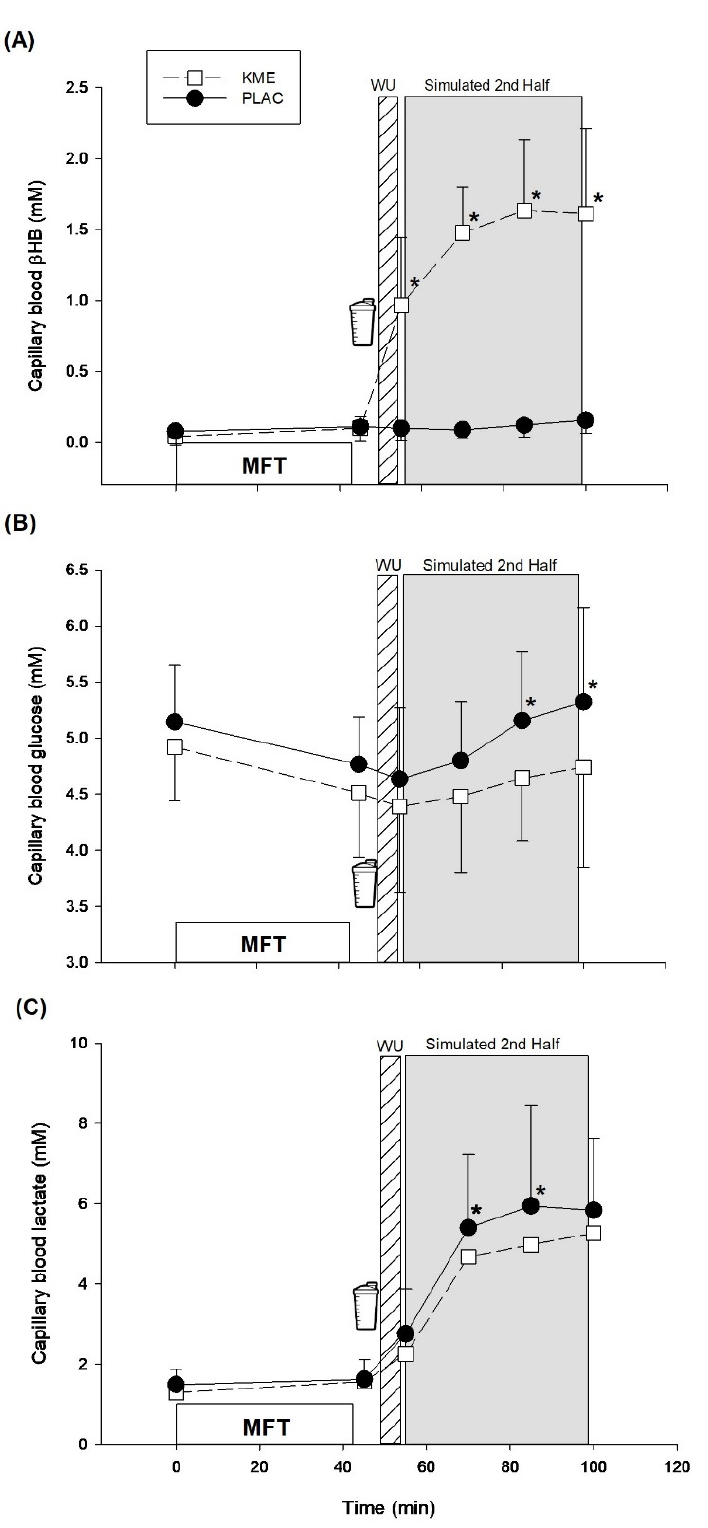
Figure 2. Effects of KME ingestion on blood metabolites during exercise after induced mental fatigue. ( A ) blood β HB concentration ( B ) blood glucose concentration ( C ) blood lactate concentration. Values are means ± SD. MFT = mental fatiguing task; WU = warm-up; KME = ketone monoester supplement; PLAC = non-caloric placebo. * Significantly different versus PLAC.